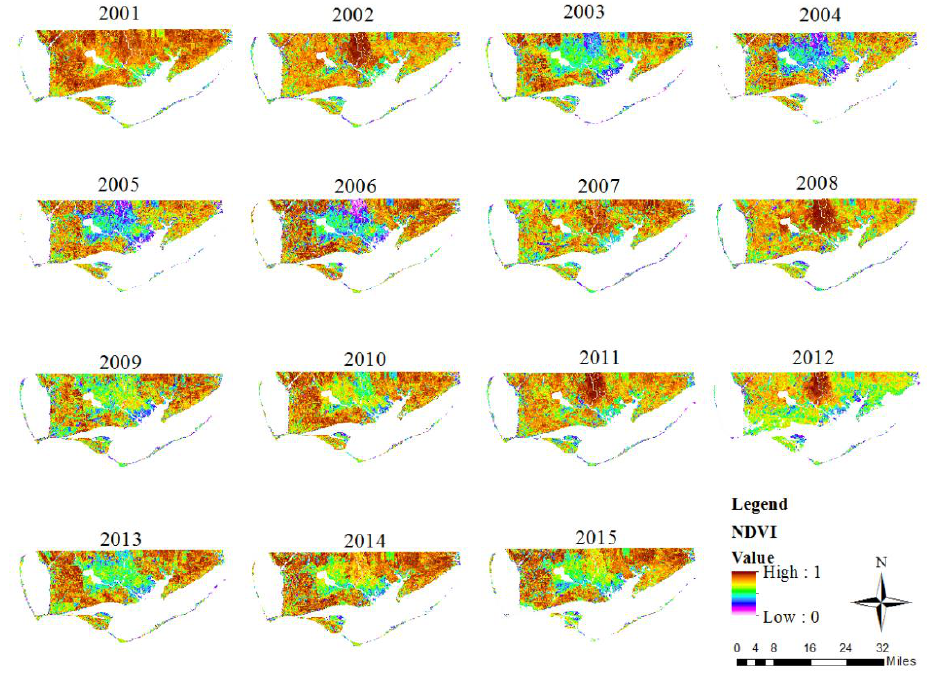
Figure 1. Temporal pattern of annual averaged Normalized Difference Vegetation Index (NDVI) from 2001 to 2015. Low NDVIs were observed during 2003–2005 (known hurricane years), 2009 (known hurricane year) and 2012–2013 (known drought and tropical storm years).